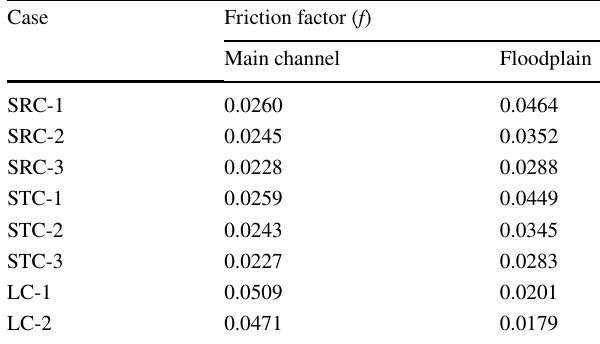
Table 2 Friction factors for all test